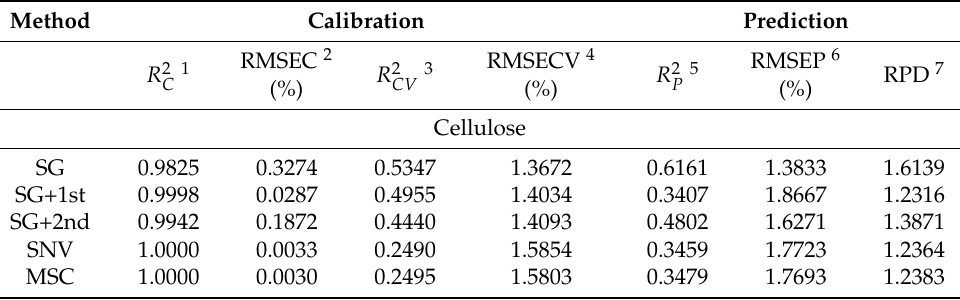
Table 3. Performance of the full-PLSR models with different pretreatment